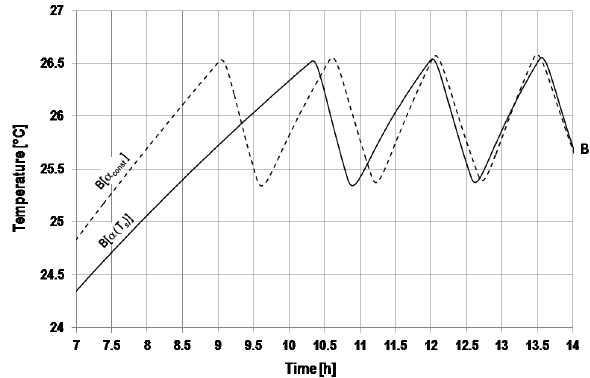
Figure 8: Temperature profiles at point B of the model of a floor heater with variable α ( T s ) and constant heat transfer coeflcient α const